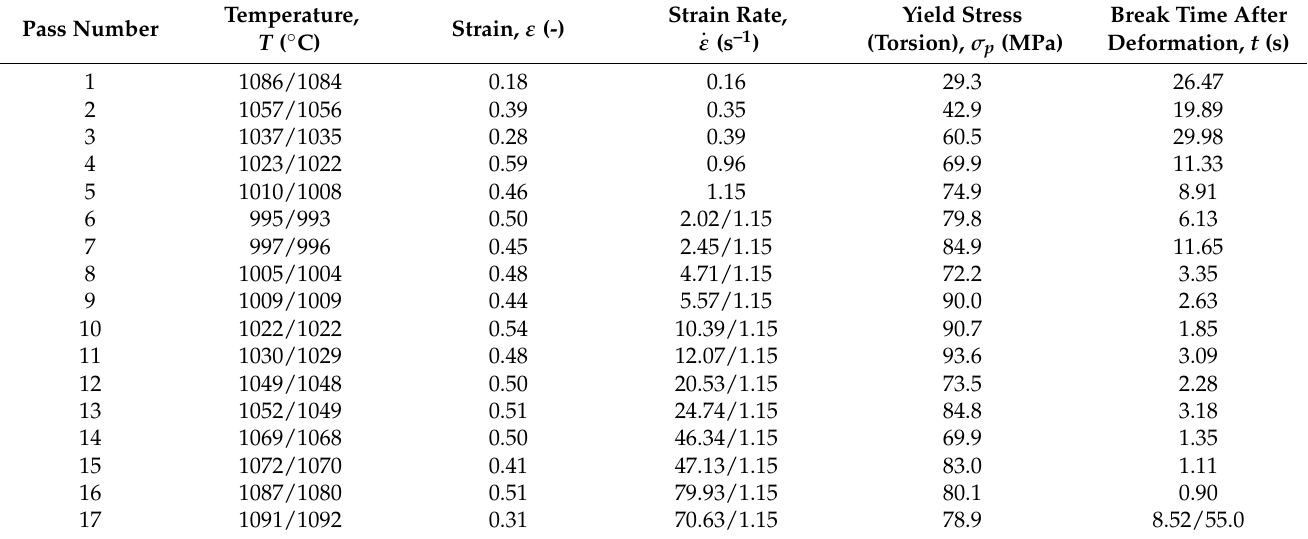
Table 2. Parameters of the deformation process during physical modelling of rolling a round 20MnB4 steel rod in a medium continuous rolling mill, for rolling a 5.5 mm diameter wire rod (research variants: V1, V2, and V3) [17,21].